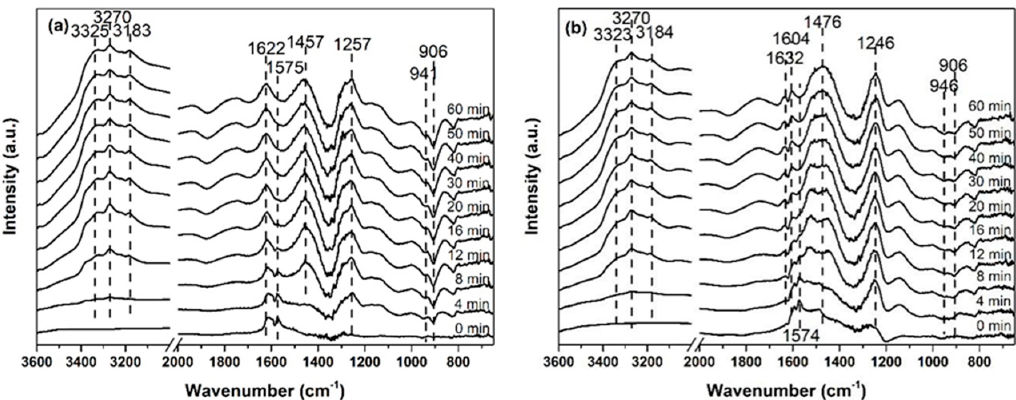
Figure 7. In situ DRIFTS spectra of ( a ) Cu-SSZ-13 and ( b ) 5% Mn/Cu-SSZ-13. Catalysts were exposed to 1000 ppm NO/N 2 and 5% O 2 until saturated and then purged by N 2 to remove weakly absorbed NO and O 2 . 1000 ppm NH 3 /N 2 was introduced at 0